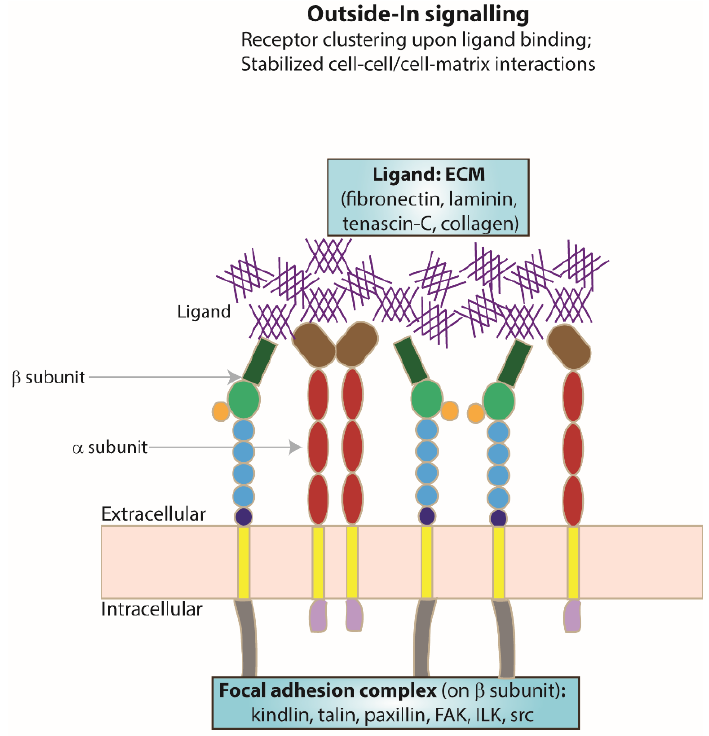
Figure 2. Focal adhesion formation. Schematic representing integrin receptor clustering at the membrane as an example of receptor activation, a result of ligand (ECM) binding and one of the resulting changes following ’outside–in’ signalling.